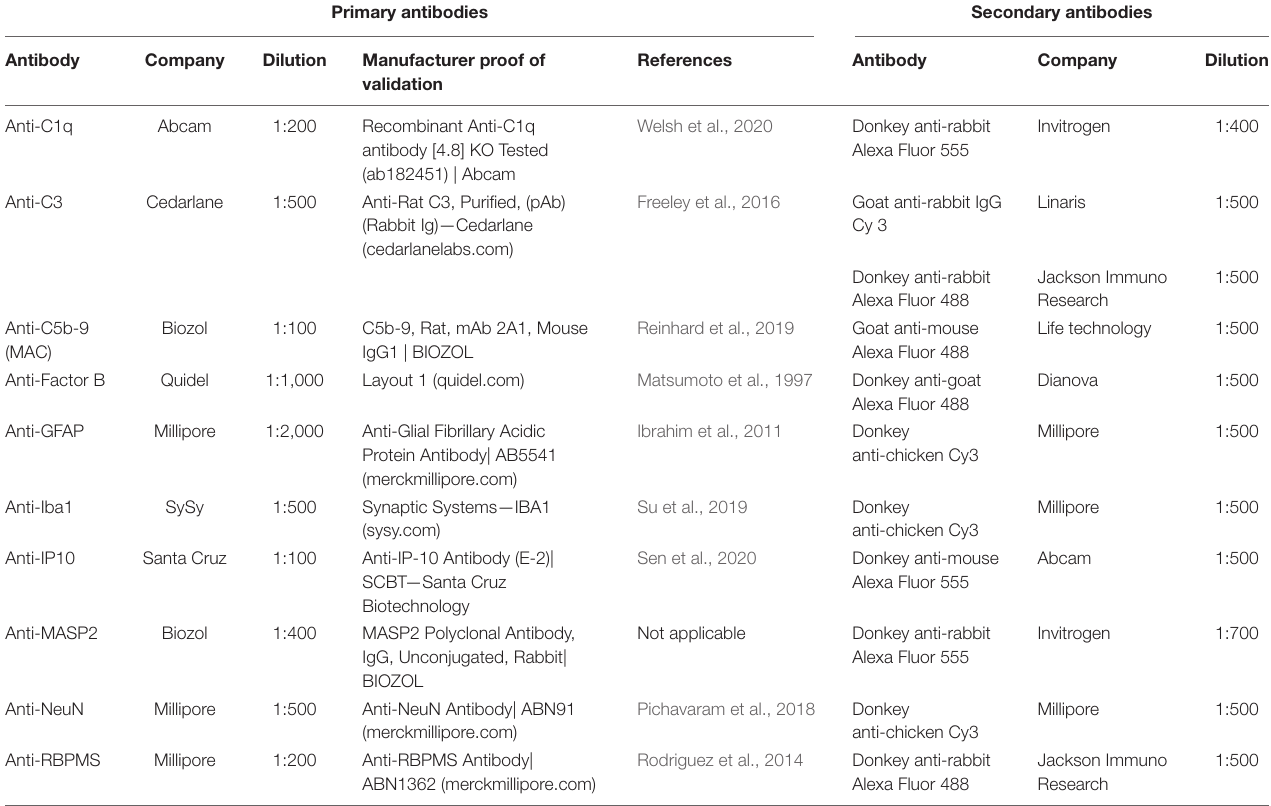
TABLE 2 | Primary and secondary antibodies used for